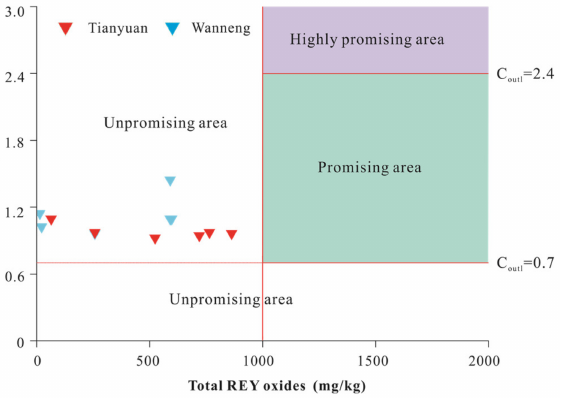
Figure 8. Evaluation diagram of cut-off grade vs. C outl values of coal and its by-products from the WN and TY power plants. The evaluation method was adopted from Dai et al.